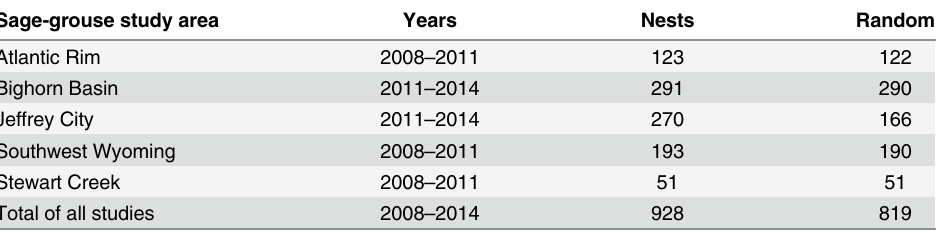
Table 1. Summary of nest and random location sample sizes used for occurrence, availability (ran- dom-random), and nest success analyses, in central and southwestern Wyoming, USA, 2008 – 2014. Sage-grouse study